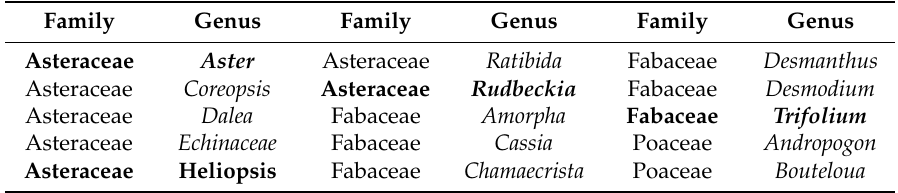
Table 1. Plant families and genera included in the CP42 pollinator seed mix. Bold type indicates plants detected in pollen samples collected by honey